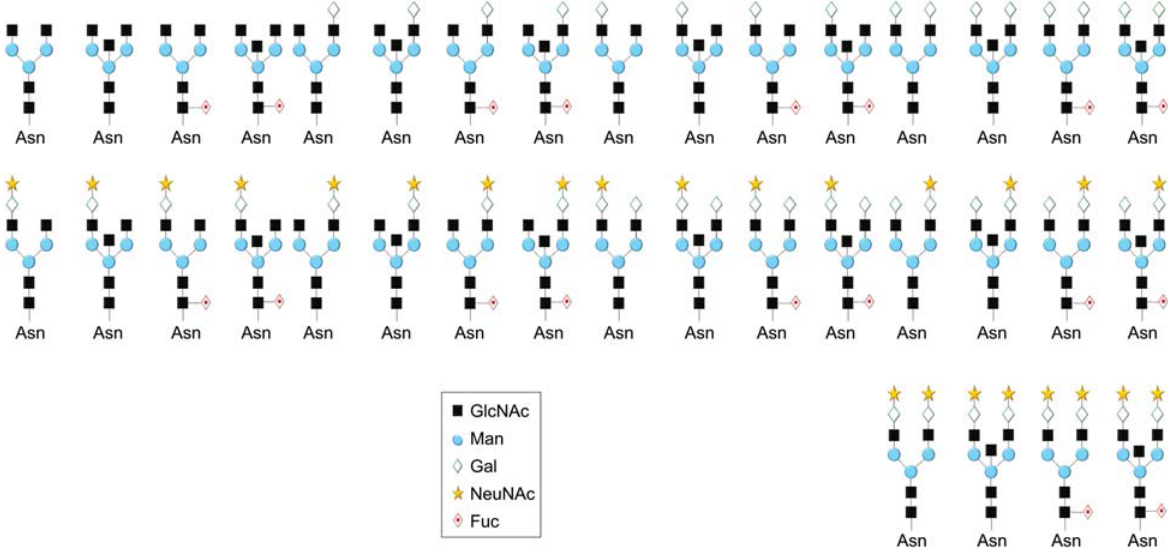
Figure 1 Structures of glycans on IgG heavy chains. Structures of the main neutral, monosialylated and disialylated glycans which can be attached to conserved Asn are shown. These glycans have a common core composed of two core N-acetylglucosamines (squares), three core mannoses (circles) and two antennary N-acetylgalactosamines, but they differ in the number of galactoses (diamonds) and sialic acids (stars) on the antenna, and the presence or absence of N-acetylglucosamine attached to the first core mannose and the presence or absence of fucose (diamond with a dot) attached to the first core N-acetylglucosamine. Glycan structures significantly affect binding of IgG to its receptors and modulate functions of IgG in the immune